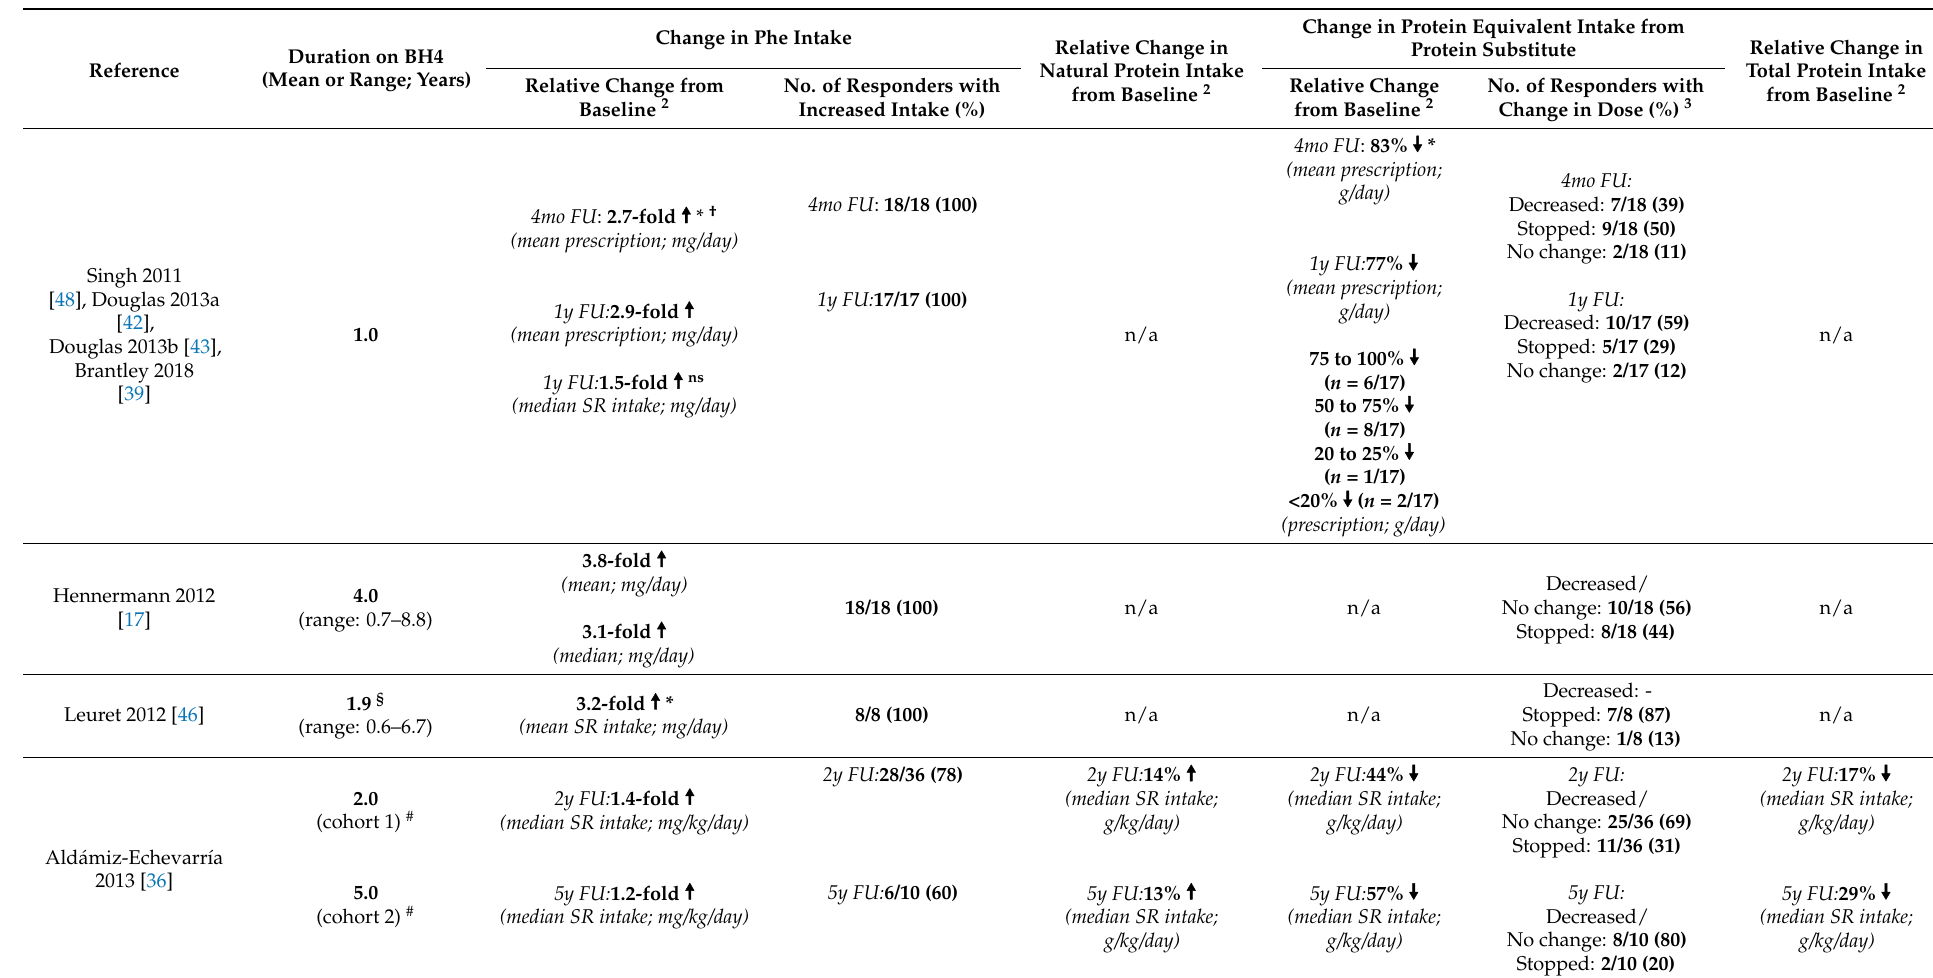
Table 2. Overview of study results: changes in phenylalanine and protein intakes (total protein, natural protein, and protein equivalent from protein substitute) of long-term responders on tetrahydrobiopterin (BH4) treatment 1 .